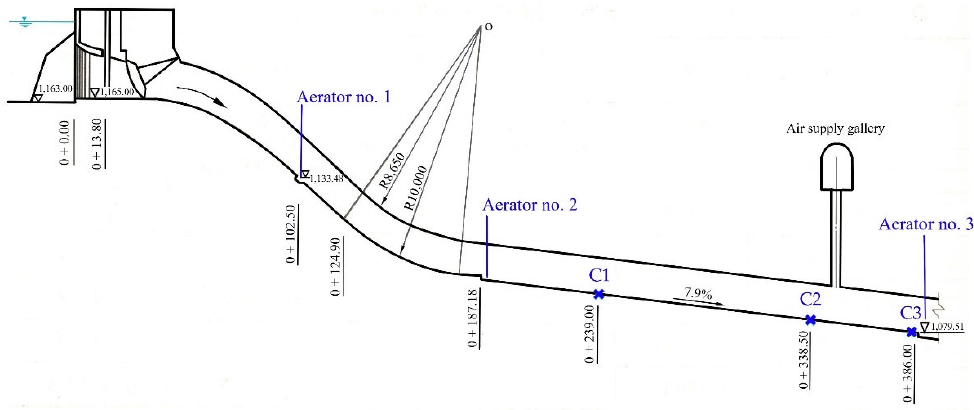
Figure 15. Layout of Ertan flood discharge tunnel, with five aerators (three are shown here). C1, C2 and C3 are prototype measurement points of bottom air concentration.